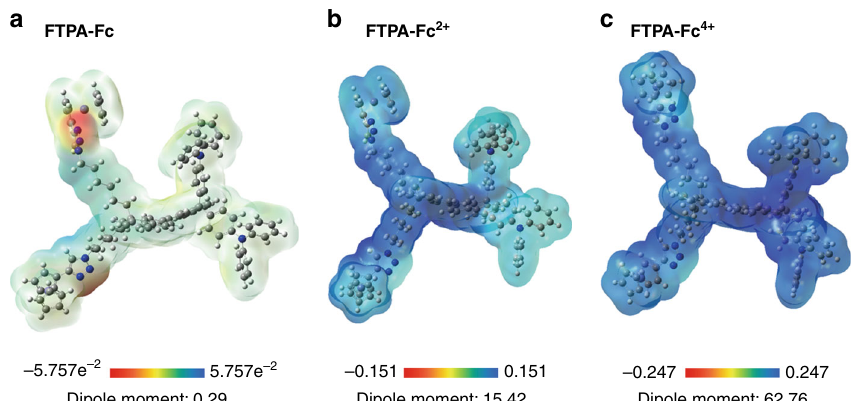
Fig. 3 Electrostatic potential (ESP) distributions of the FTPA-Fc repeating unit. Simulated ESP pro fi le in different oxidation states of a prinstine FTPA-Fc, b FTPA-Fc 2 + , and c FTPA-Fc 4 + , respectively. The gray, white, blue and light purple spheres represent carbon, hydrogen, nitrogen, and iron atoms,